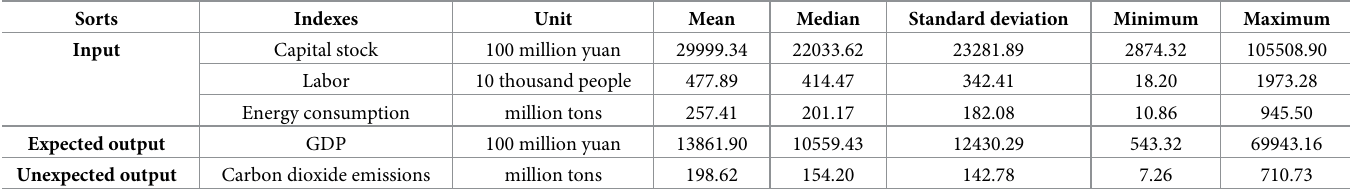
Table 2. System of regions’ carbon emission performance input-output index.